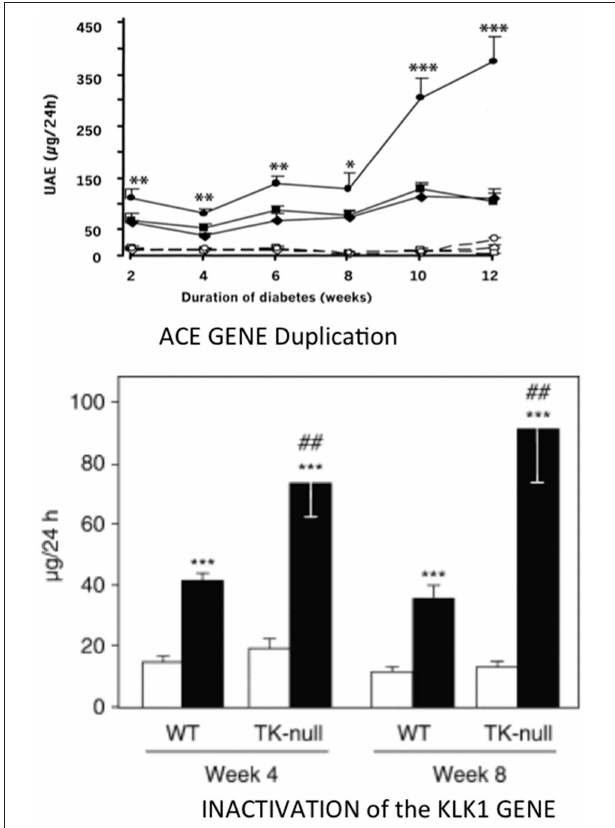
FIGURE 5 | Aggravating effect of inactivating the KLK1 gene or duplicating the ACE gene on development of diabetic nephropathy in diabetic mice . Ordinate in both graphs: urinary albumin excretion. Upper graph, ACE gene titration; open symbols, non-diabetic mice; filled symbols, diabetic mice. Diamonds, one-copy mice; squares, two-copy mice (wild-type); circles, three-copy mice. * p < 0.05, ** p < 0.01, *** p < 0.001 compared to diabetic two-copy (WT) or one-copy mice. Lower graph: K1 gene inactivation. open bars control, non-diabetic mice; filled bars diabetic mice. *** p < 0.001 compared to non-diabetic mice. ## p < 0.01 compared to corresponding WT mice. Adapted from Bodin et al. (77) and Huang et al.